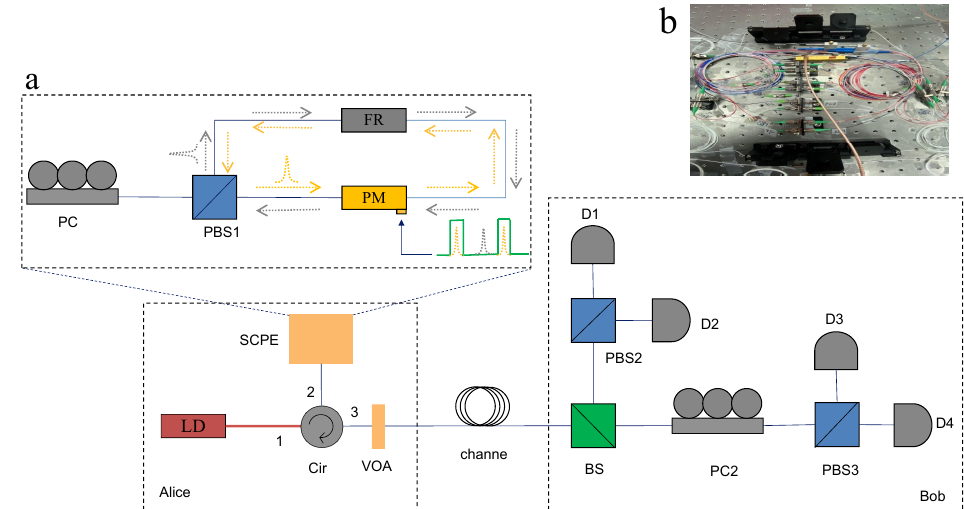
Figure 1. Schematic and experimental diagram of the QKD system. ( a ) Schematic diagram of SCPE LD, laser diode (Qasky Co. Ltd., Wuhu, China); Circ, circulators; PC, polarization controller; PBS, polarized beam splitter; PM, phase modulator (China Electronics Technology Group Co. Ltd., Chongqing, China); FR, Faraday rotator; VOA, variable optical attenuator; D1–D4, single-photon detector (Langyan Optoelectronic Technology Co. Ltd., Shanghai, China). ( b ) Experimental setup of the QKD